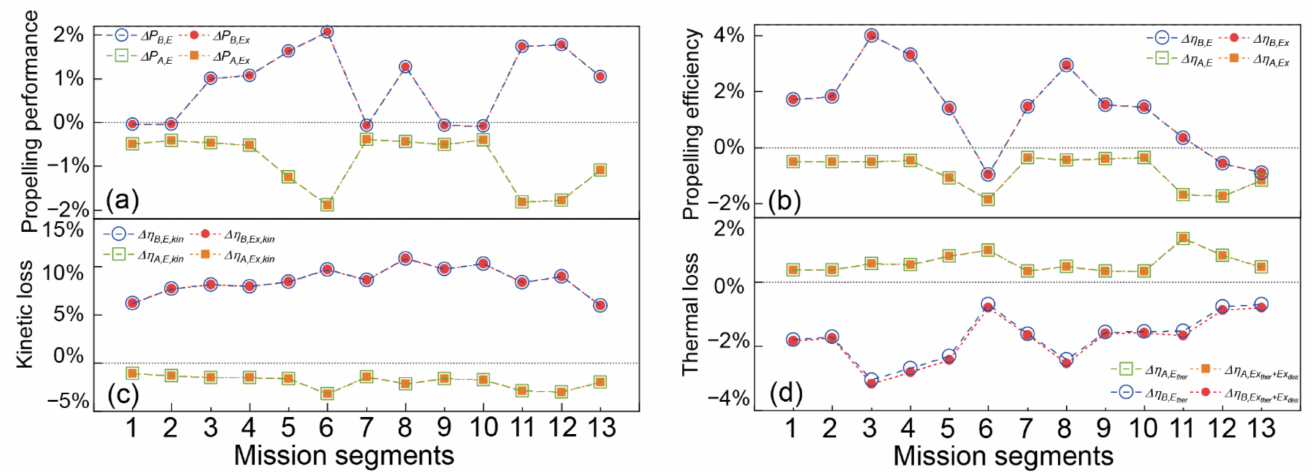
Figure 8. Comparison of the overall performance between scheme A/B with F-119 by energy and exergy methods. ( a ) Propelling energy and exergy; ( b ) Propelling energy and exergy efficiency; ( c ) Energy and exergy kinetic loss; ( d ) Thermal